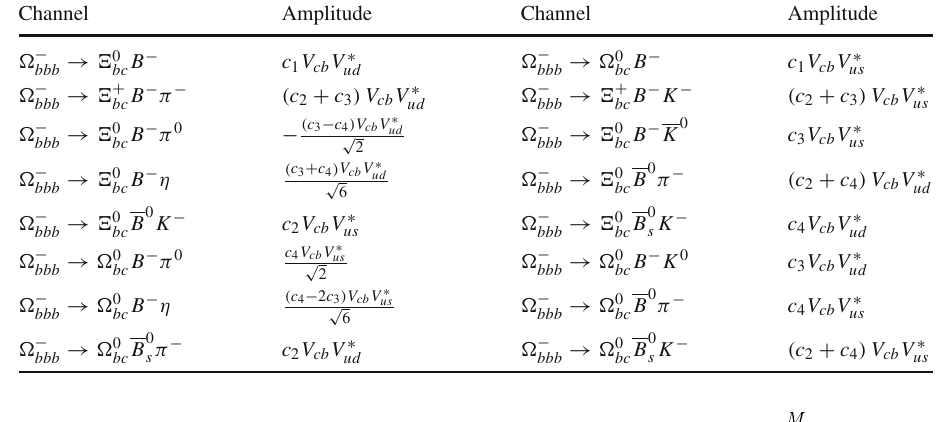
Table 5 Amplitudes for (cid:2) − decays into a T bc and a B -meson and a light meson